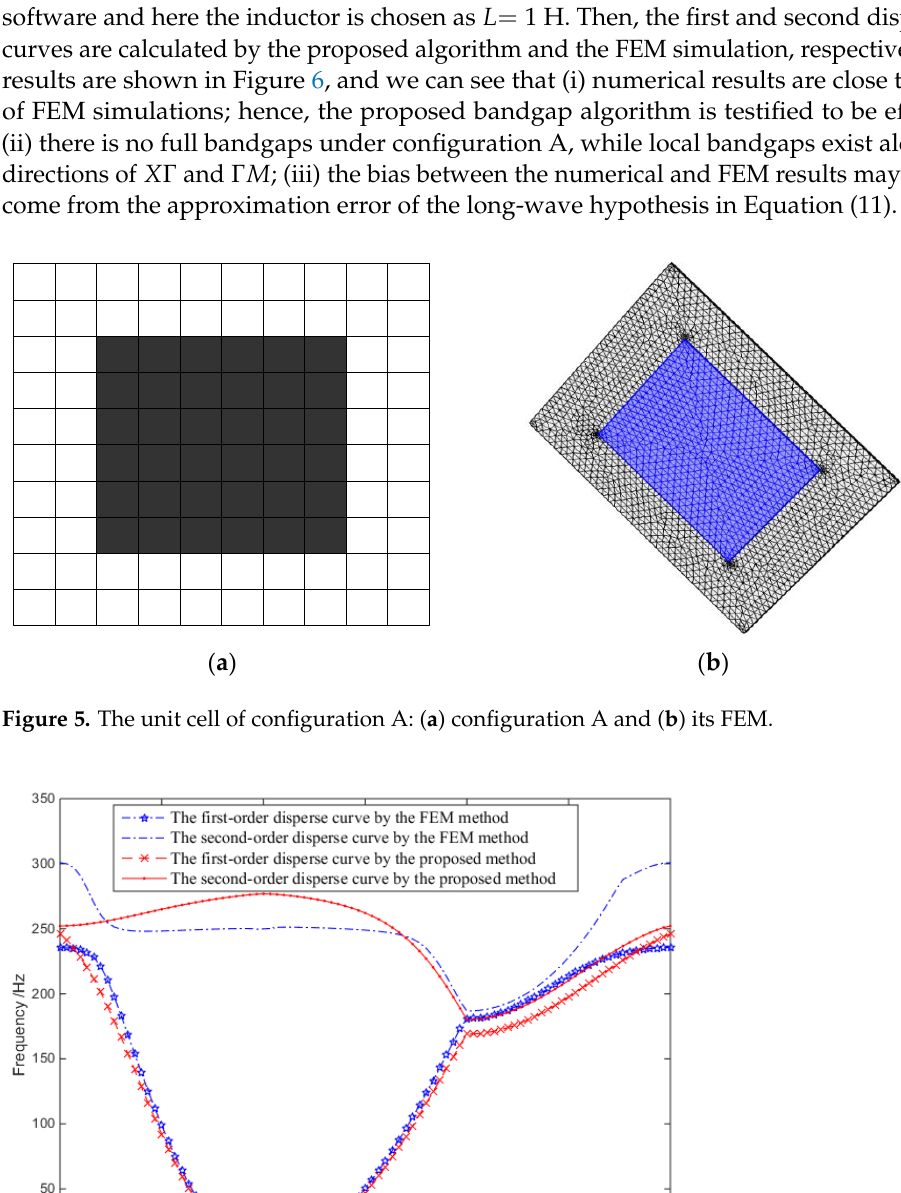
Figure 7. The unit cell of configuration B. Firstly, the inductor is chosen as =1 L